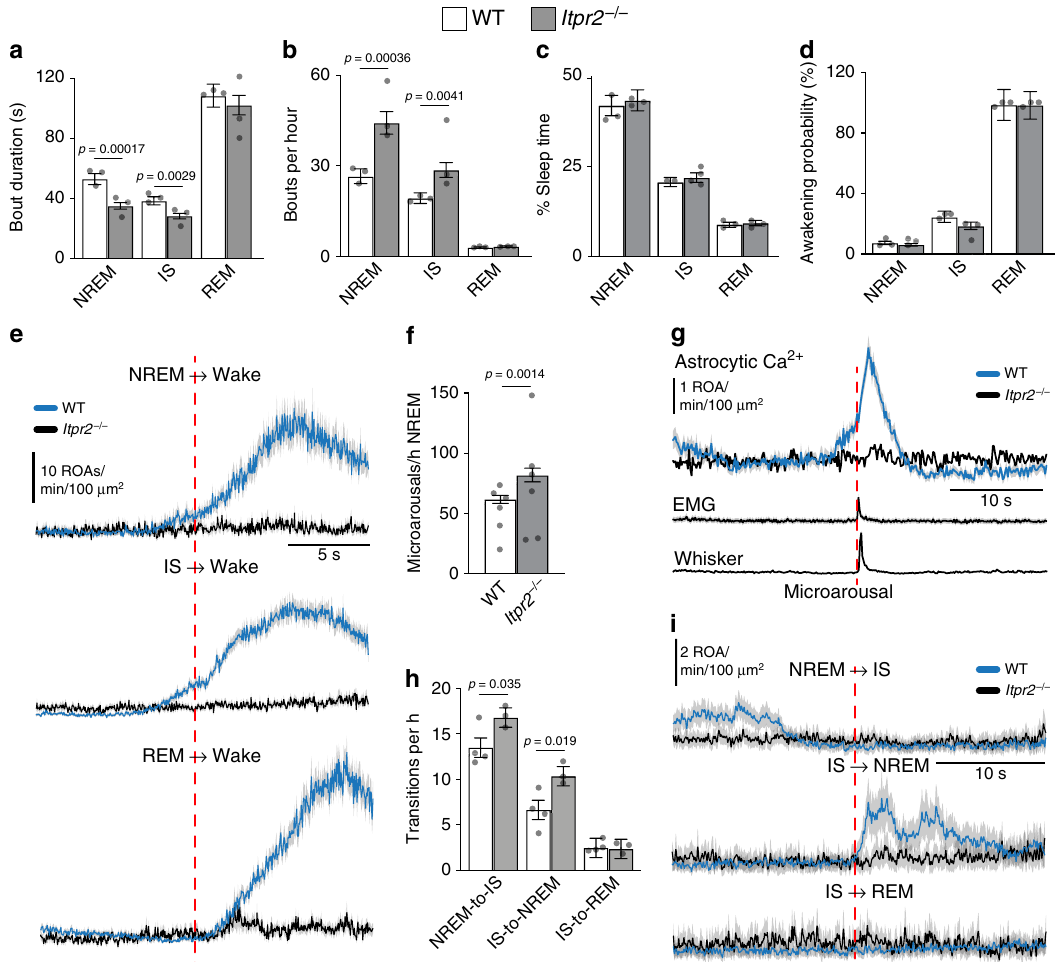
Fig. 8 Astrocytic IP 3 -mediated Ca 2 + signaling pathway regulates SWS. a – c Bout duration ( a ), bouts per hour ( b ), and percentage recording time ( c ) of NREM, IS, and REM sleep in WT and Itpr2 − / − mice. For WT mice: n = 3 mice, 806 NREM episodes, 617 IS episodes, 92 REM episodes; for Itpr2 − / − mice: n = 3 mice, 1140 NREM episodes, 787 IS episodes, 86 REM episodes. d Awakening probability calculated as awakenings from NREM, IS, or REM sleep divided by total number of NREM, IS, or REM episodes. For WT mice: n = 4 mice, 806 NREM episodes, 617 IS episodes, 92 REM episodes; for Itpr2 − / − mice: n = 3 mice, 1140 NREM episodes, 787 IS episodes, 86 REM episodes. e Mean ± SEM of astrocytic Ca 2 + signals during transitions from NREM, IS, or REM sleep to wakefulness. For WT mice: n = 6 mice, 59 NREM awakenings, 141 IS awakenings, 87 REM awakenings; for Itpr2 − / − mice: n = 6 mice, 23 NREM awakenings, 56 IS awakenings, 27 REM awakenings. f Frequency of microarousals during NREM sleep. For WT mice: n = 6 mice, 355 microarousals; for Itpr2 − / − mice: n = 6 mice, 240 microarousals. g Mean ± SEM of (top to bottom) astrocytic Ca 2 + signals, z -scores of EMG activation and